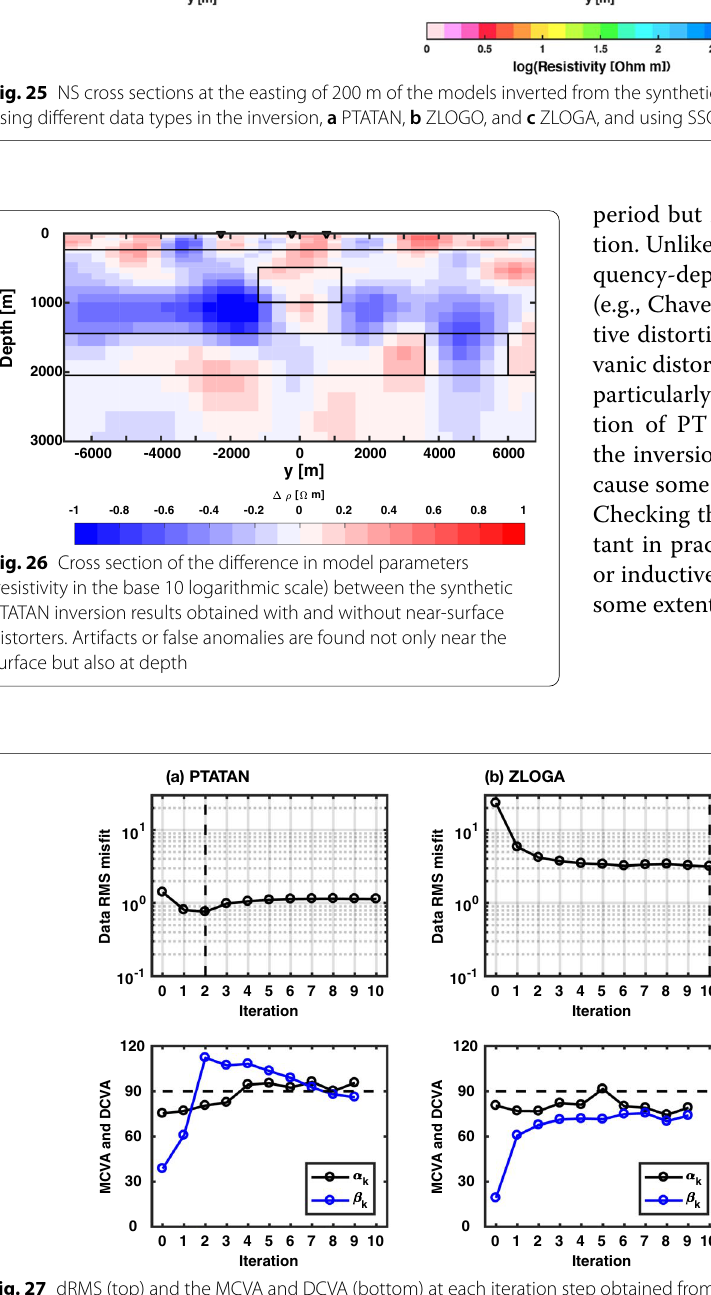
Fig. 27 dRMS (top) and the MCVA and DCVA (bottom) at each iteration step obtained from inverting a PTATAN, b ZLOGA, and c ZLOGO derived from the synthetic model with near‑surface distorters using SSQ1D as the initial model. The dashed line in the dRMS plots indicates the iteration step, where the dRMS is